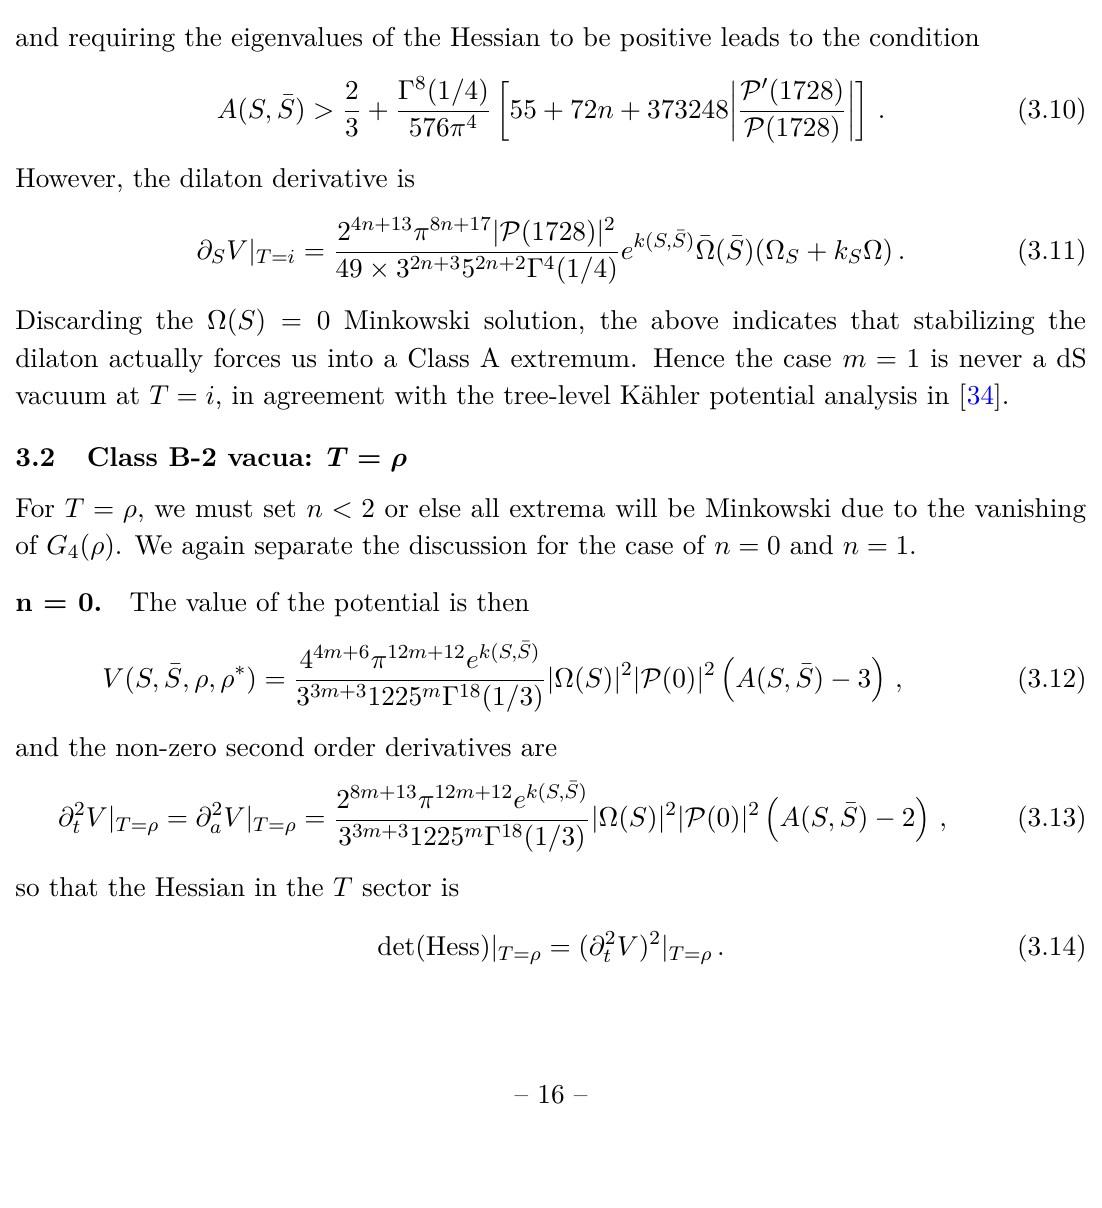
Figure 3 . Determinants of the Kähler modulus block of the Hessian at T = i with ( m, n ) = (0 , n ) and polynomials given by P ( j ( T )) = 1 (left) and P ( j ( T )) = 1 + j ( T ) (right). The orange segments correspond to dS vacua assuming a stabilized dilaton. The vertical asymptote indicates the point where the determinant crosses to negative